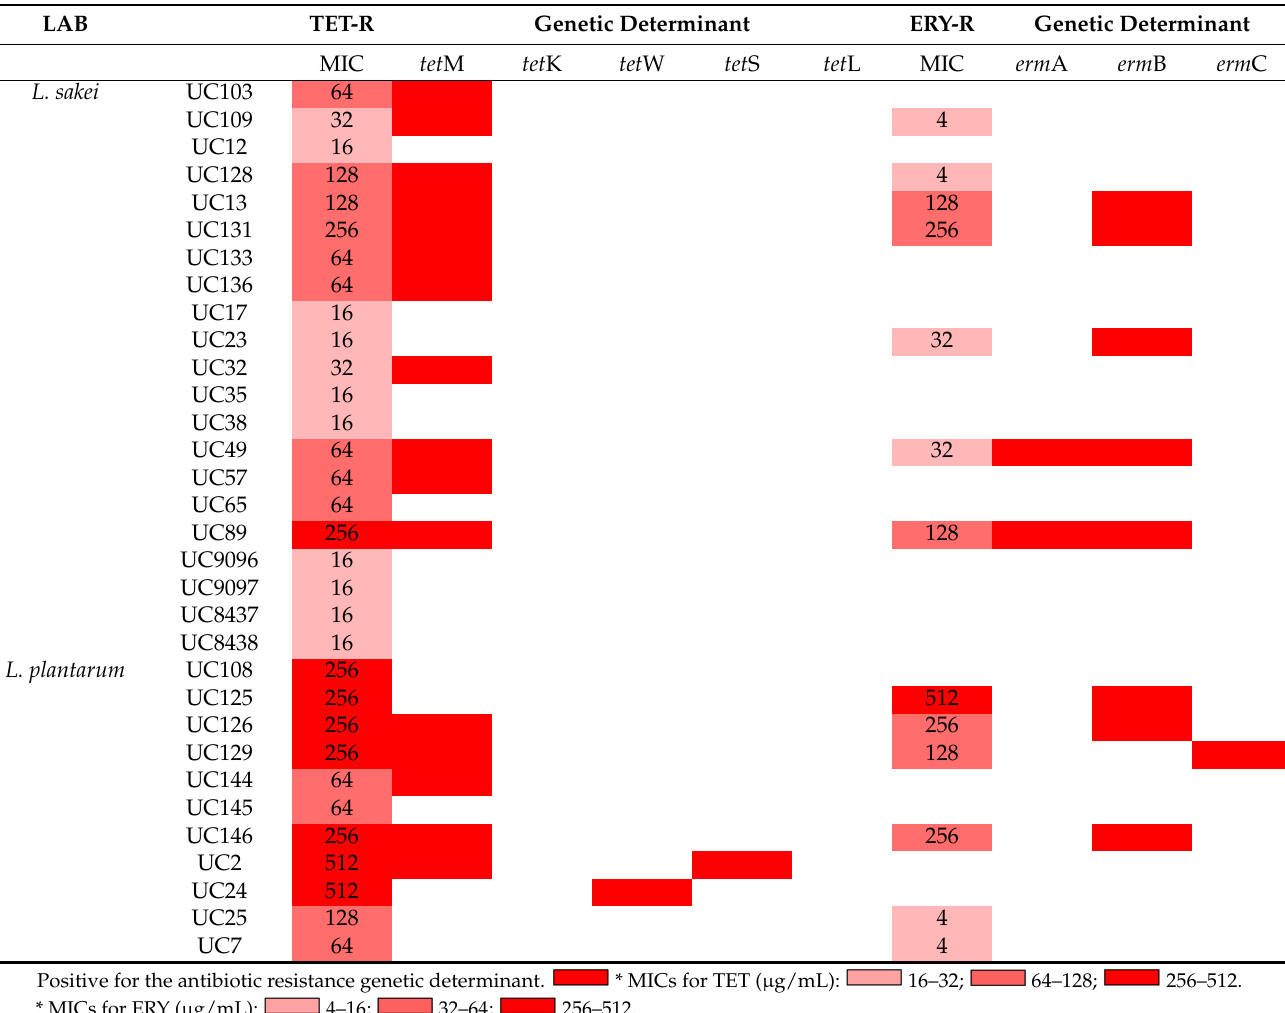
Positive for the antibiotic resistance genetic